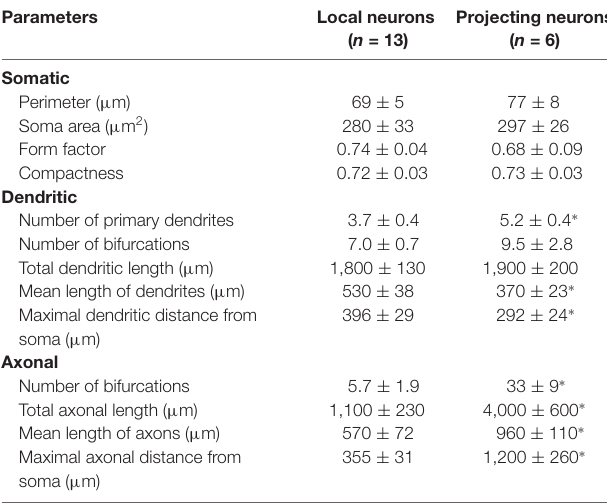
TABLE 1 | Quantification of the morphology of glycinergic neurons in the preBötC. Parameters Local neurons Projecting neurons